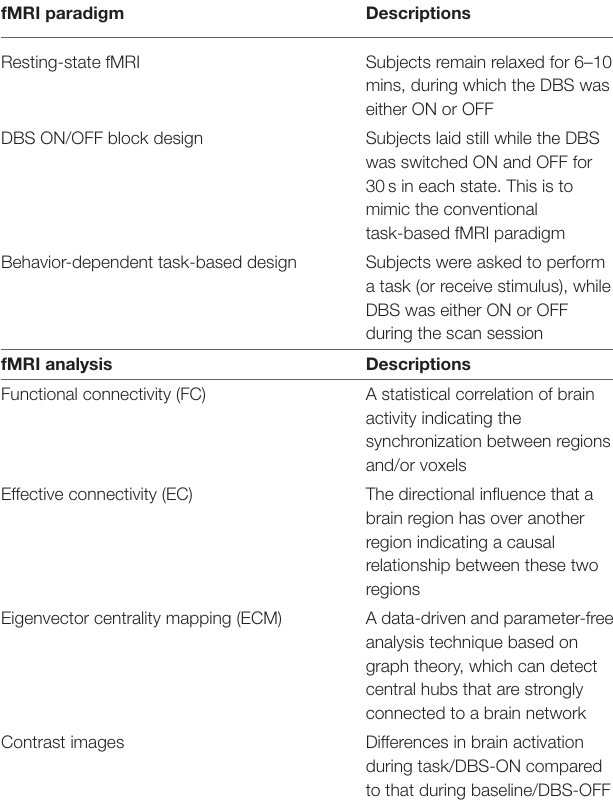
TABLE 1 | Summary of the types of functional MRI (fMRI) paradigms and analyses. fMRI